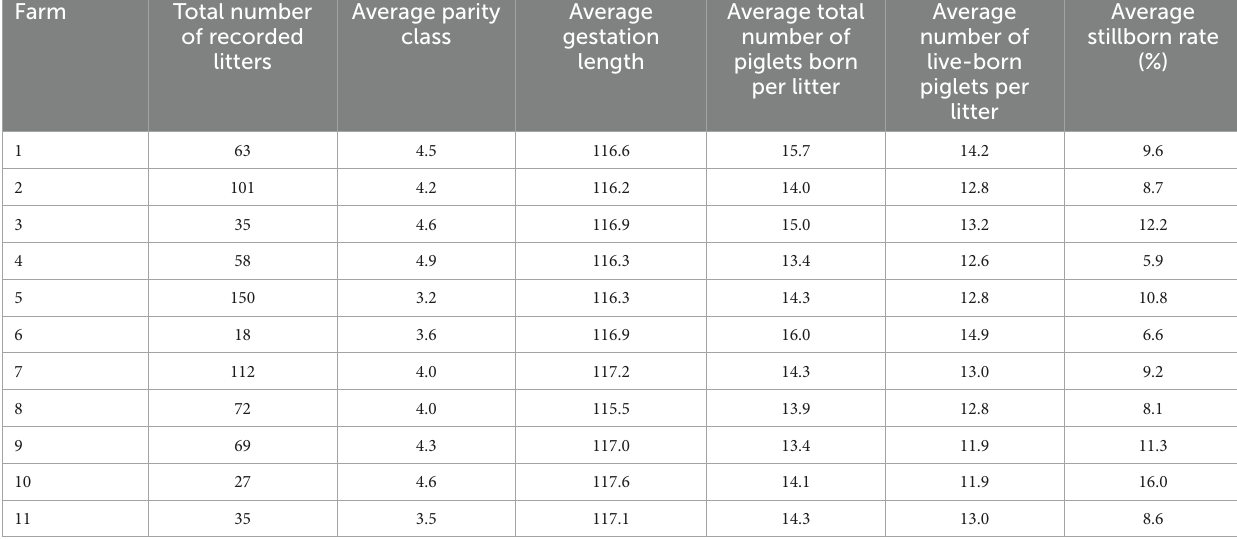
TABLE 1 Information on number of litters included in the analysis, sow characteristics, and litter performance per